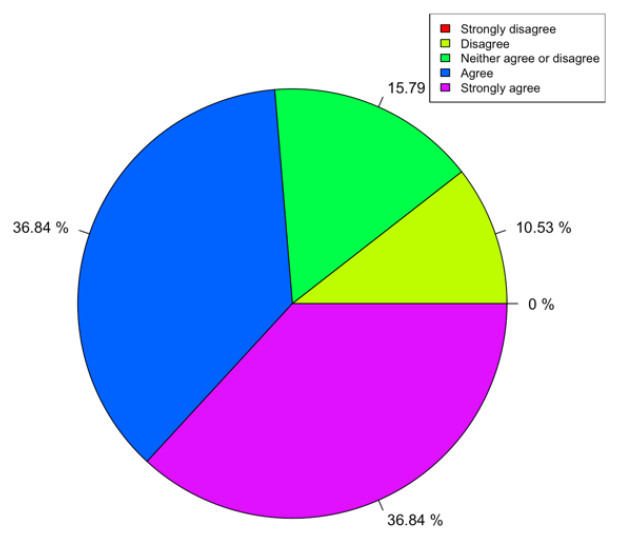
Figure 10. Survey results on students’ answers to Q8.